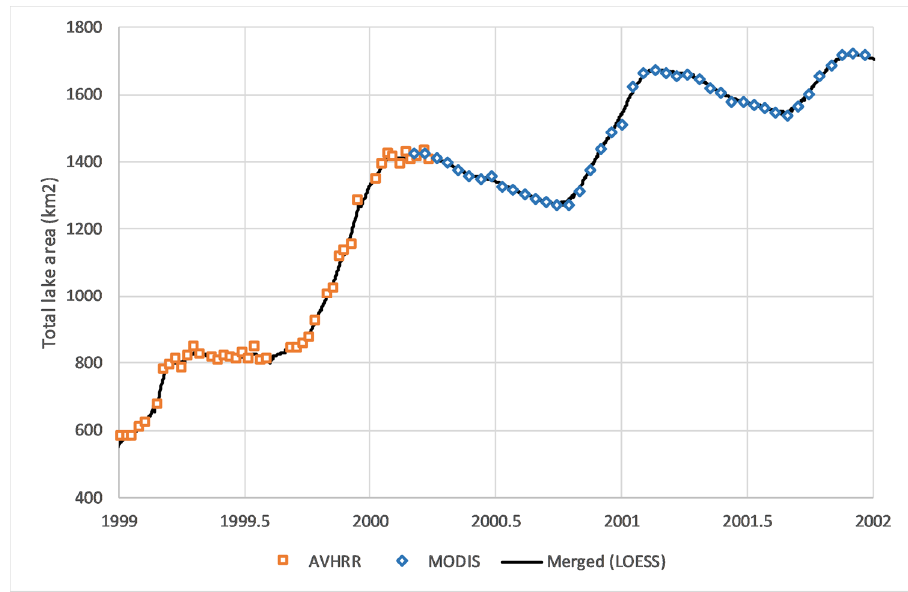
Figure 5. Combination of lake surface area measurements from the Advanced Very High Resolution Radiometer (AVHRR; orange squares) and MODIS (blue diamonds) with interpolation using a locally estimated scatterplot smoothing (LOESS) regression model (black line) at a daily timestep. Area (in km 2 ) is total for all six lakes.